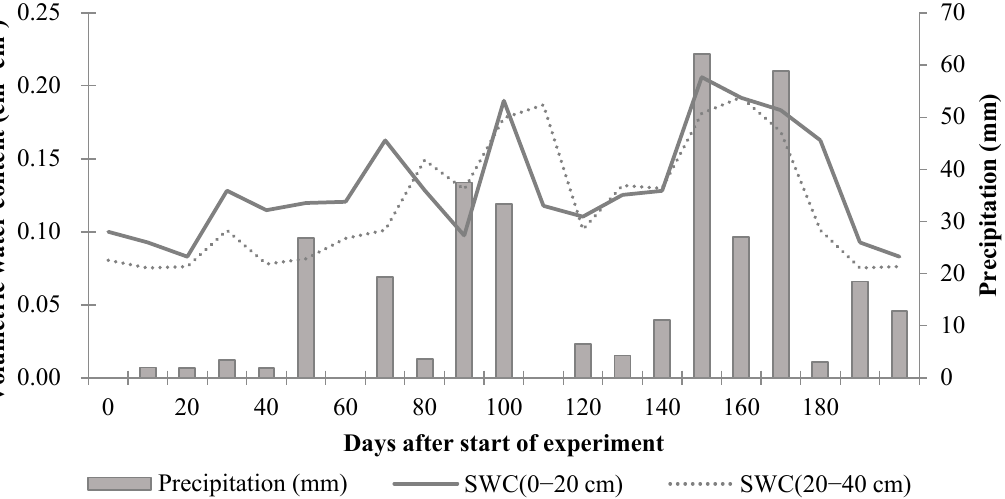
Figure 8. Observed soil volumetric soil moisture content and precipitation events tested in fields at